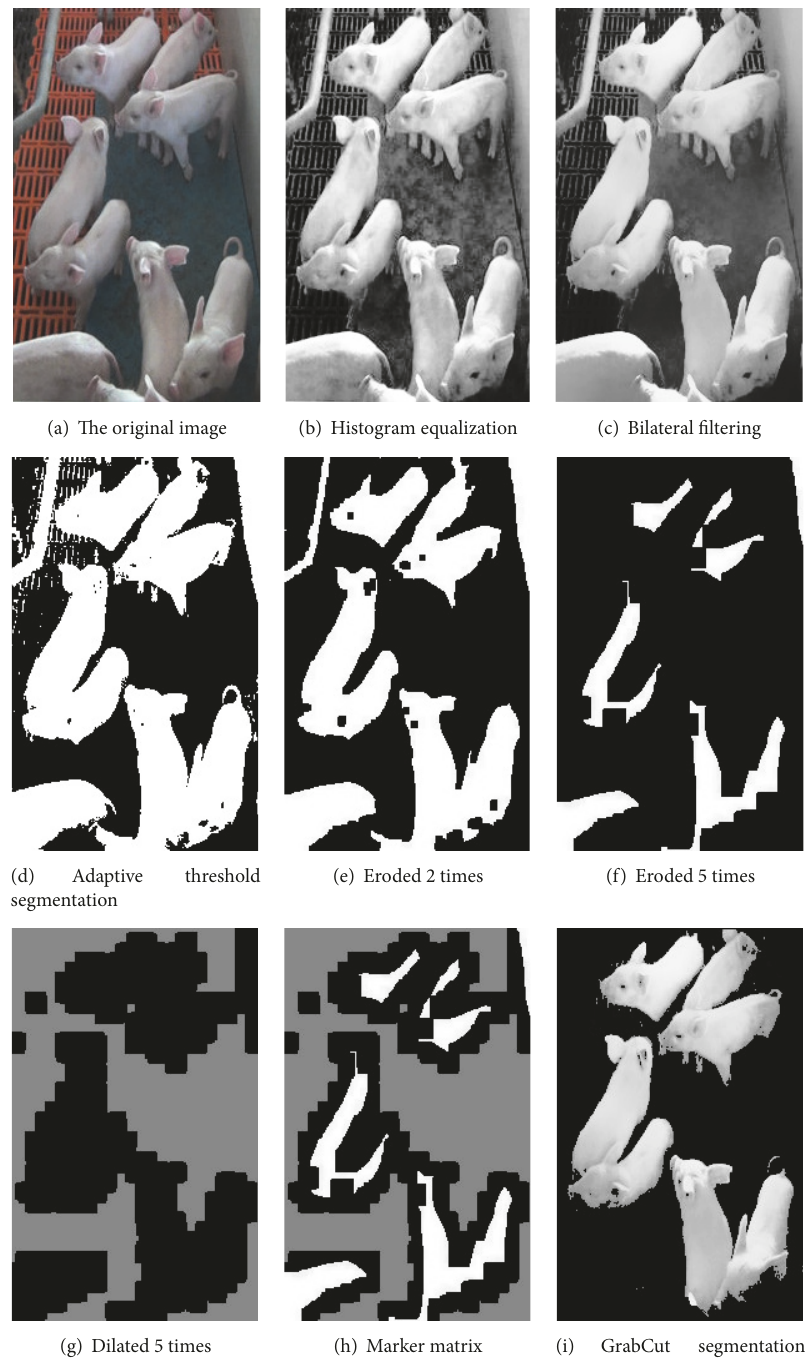
Figure 2: The segmentation of images of piglets by a noninteractive GrabCut